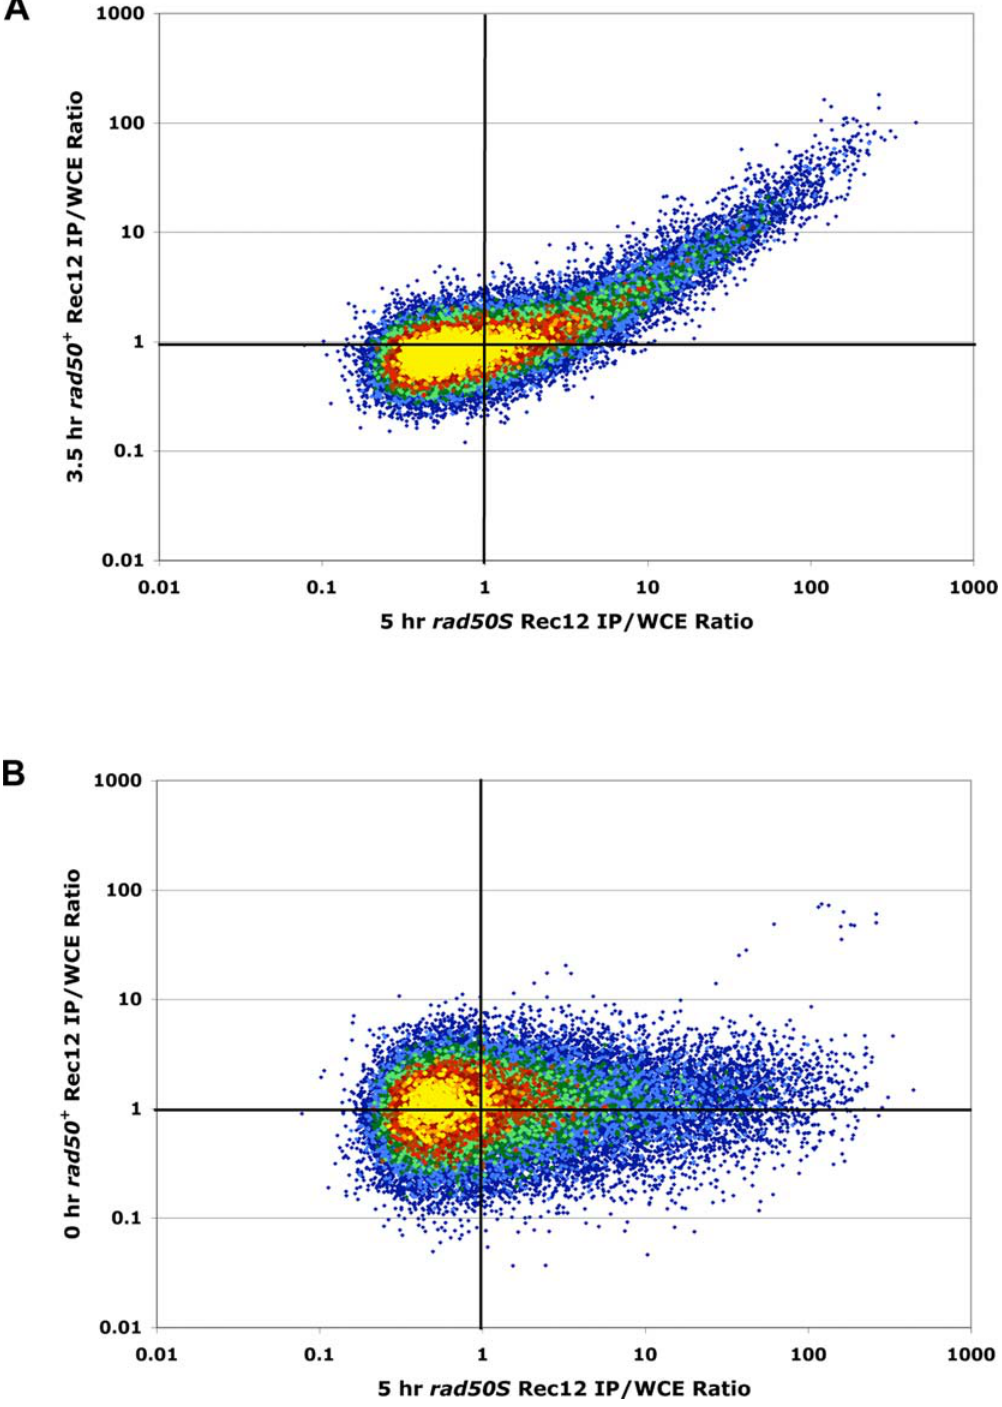
Figure 5. Essentially All DSB Hotspots Detected in rad50 + Are Also DSB Hotspots in rad50S . The Rec12 IP/WCE ratio of each probe in the rad50 + microarray hybridization is plotted against the IP/WCE ratio of the same probe in the 5 h rad50S microarray hybridization, using Dataset S2. Color indicates density of plotted points with yellow highest and dark blue lowest (see Figure S6). The plots are on a log scale. (A) The 3.5 h rad50 + IP/ WCE ratios are positively correlated with those of rad50S . Essentially all probes showing enrichment of the rad50 + DNA by Rec12 IP also show enrichment in the rad50S DNA and vice versa . (B) The uninduced (0 h) rad50 + IP/WCE ratios show no correlation with those of rad50S , as expected for uninduced background signals. Similar results were obtained in an independent induction of each strain (Dataset S1; Figure S6). In this experiment, but not the other (Figure S6), a small number of probes aberrantly displayed apparent enrichment in the 0 h rad50 + data (B, top right).